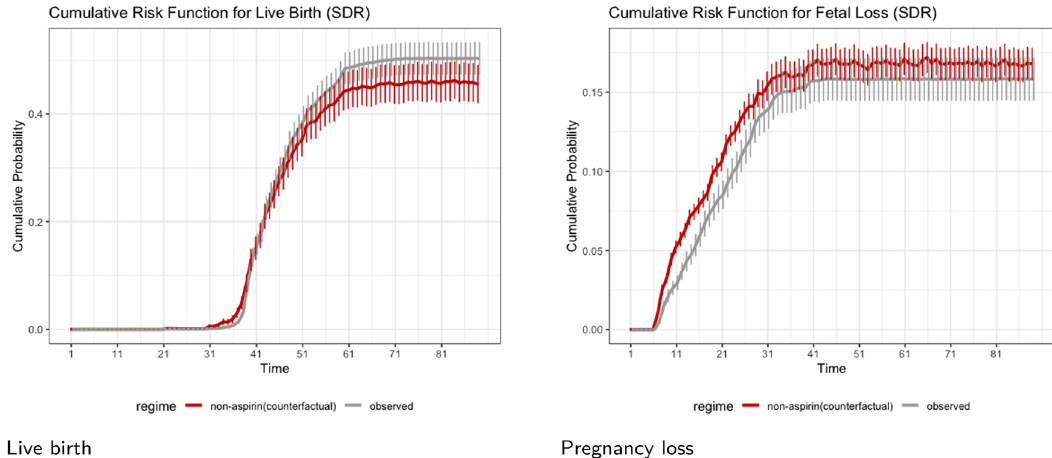
Figure A6: Cumulative risk curve for live birth and pregnancy loss via the sequential doubly robust ( SDR ) estimator. Pointwise 95% con fi dence interval is estimated by bootstrapping with 1,000